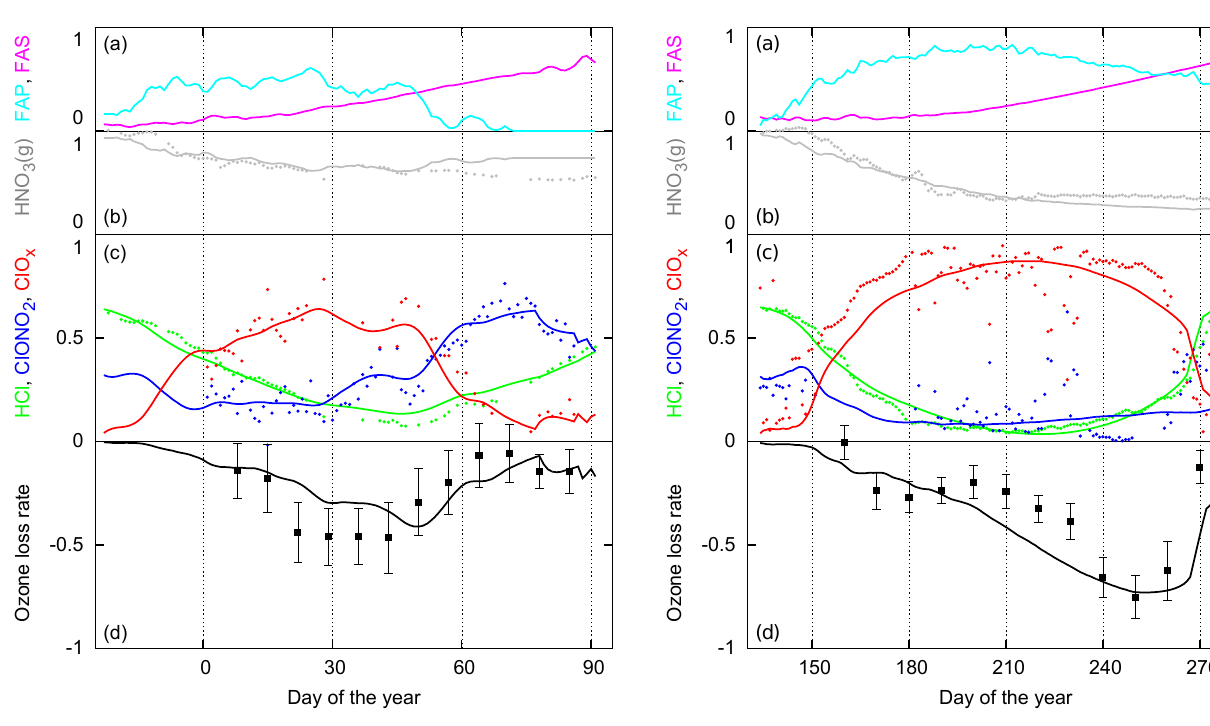
Figure 2. Overview of SWIFT results and observations for the Arc- tic winter 2004/2005. All data are shown in normalized units (more details see text). (a) FAP (cyan) and FAS (magenta). Lines in (b) – (d) represent SWIFT results; dots represent vortex-averaged obser- vations. (b) HNO 3 (gas phase, gray, observations from Aura MLS). (c) HCl (green, observations from Aura MLS), ClONO 2 (blue, ob- servations from ACE-FTS) and ClO x (red, “observed” ClO x is de- rived by using a constant Cl y minus the HCl and ClONO 2 obser- vations). (c) Ozone loss rates (observations from Match). The loss rates of normalized ozone have been multiplied by 50 to facilitate plotting on the same scale. Error bars represent 1 σ statistical uncer- tainties; an additional 20% systematic uncertainty applies.